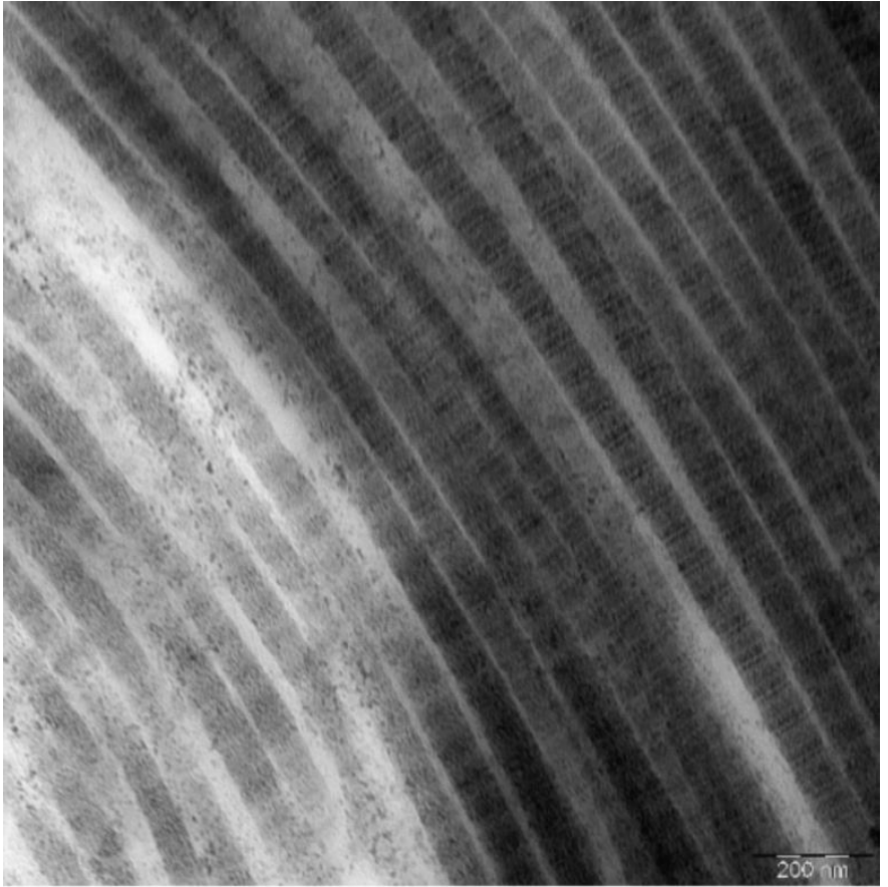
Figure 3. Electron micrograph of X-graft ® collagen fibers in longitudinal sections. Each fibril consists of regular alternating dark and light bands that are further divided by cross-striations. Scale bar is 200 nm.